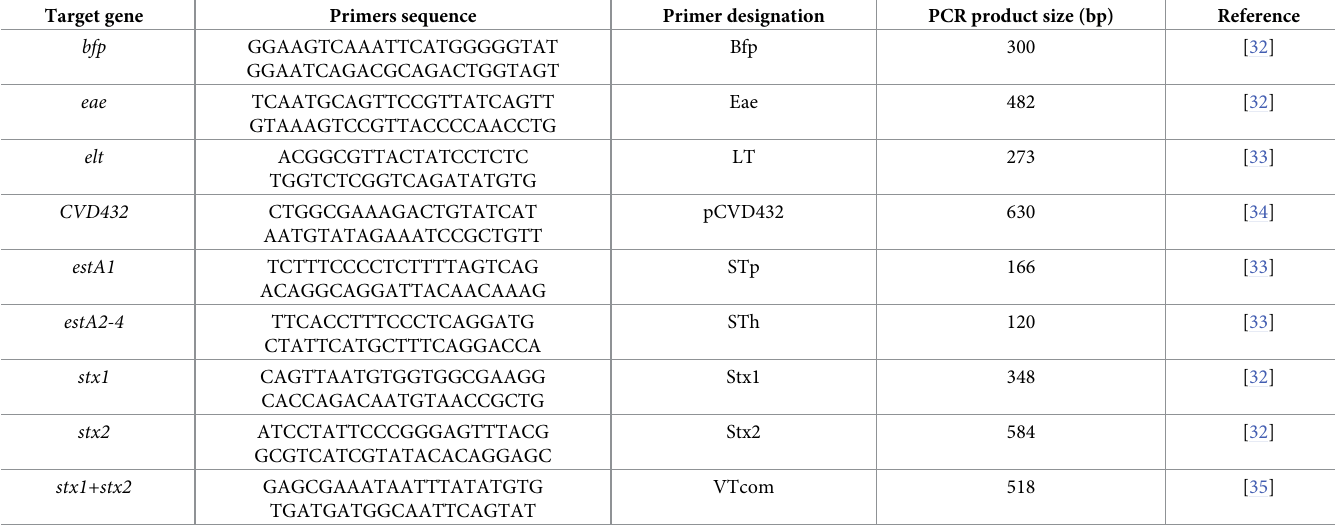
Table 1. List of primers, their sequences, and the size of the amplified products, used in this study. Target gene Primers sequence